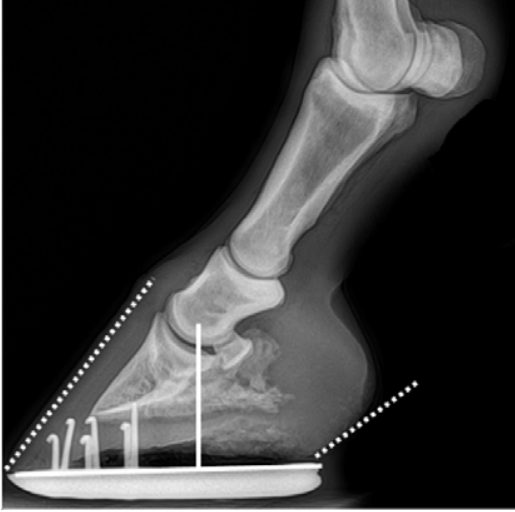
Figure 1: Lateromedial projection of the foot revealing dorsopalmar hoof imbalance in a 13-year-old Arab gelding. The vertical line from the centre of the condyles of P2 does not bisect the solar surface but is more palmar. The heel and dorsal hoof wall angles are still equal.